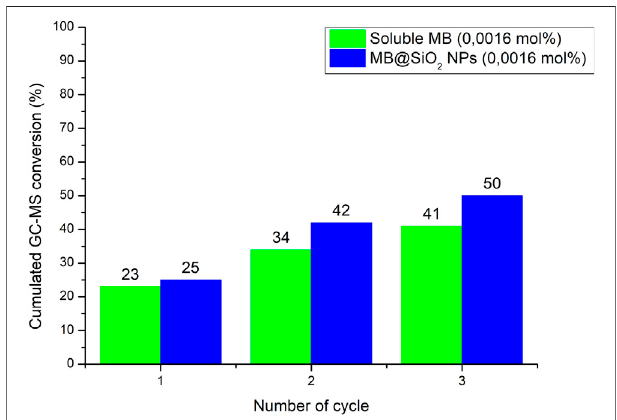
FIGURE 5| Cumulatedconversionsof 1 asmeasuredafter n cyclesinthe continuous fl owphotoreactorunderthefollowing conditions: inCH 3 CN[0.1 M], Q (organic) (cid:1) 0.25 ml · min − 1 , Q (O 2 ) (cid:1) 1.0 ml(n) · min − 1 , p (cid:1) 6 bars, T (cid:1) 20 ° C).